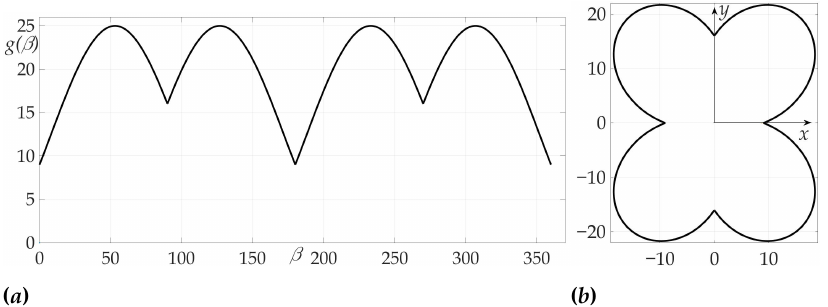
Figure 12. Radiation pattern as an dependence g ( β ) in polar coordinates ( a ) and on the Cartesian plane ( b ).